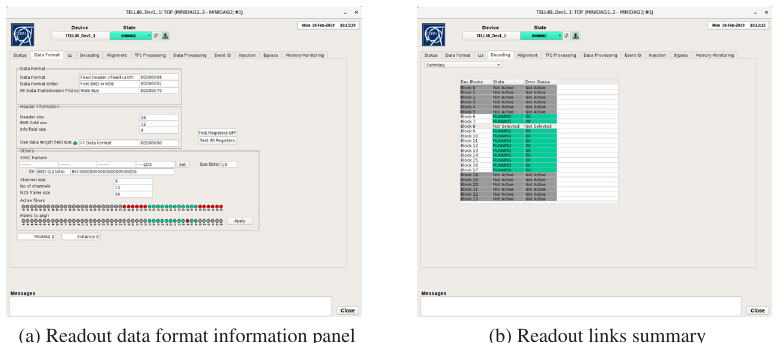
Figure 2. Example of panels from the TELL40 user